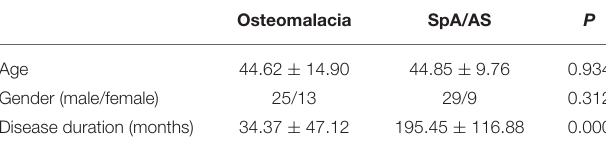
TABLE 1 | General information of patients in both groups.